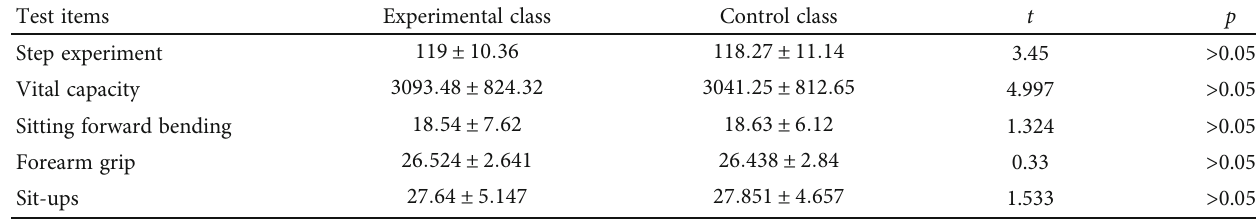
Table 1: Comparative analysis of test results of students ’ health and physical fi tness index before experiment.